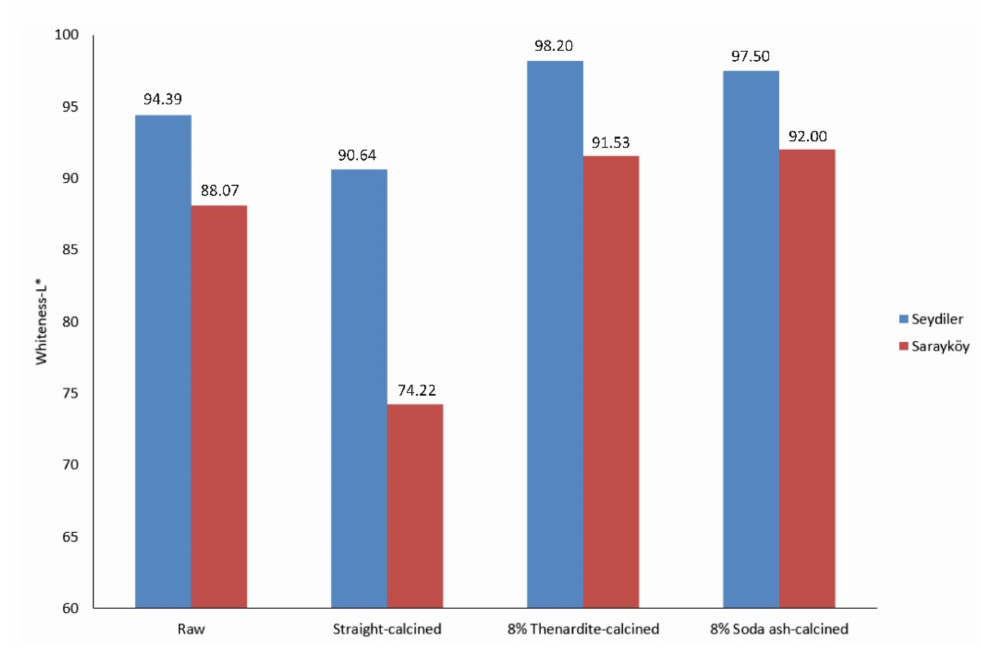
Figure 6. Whiteness ( L* ) of diatomite samples. Table 3. Colour parameters of diatomite